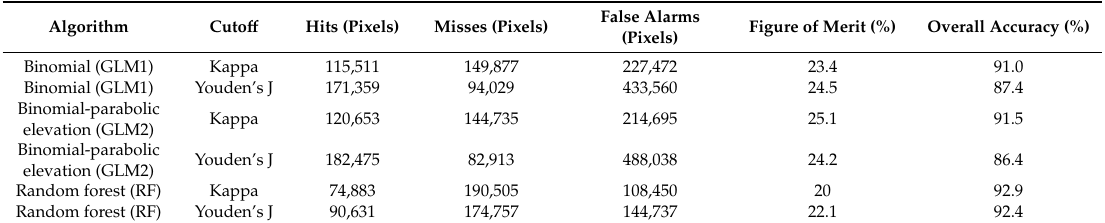
Table 2. Comparison of hits, misses, and false alarms for di ff erent algorithms of simulation of change in study area from 2008 to 2014. GLM stands for Generalized Linear regression Model.